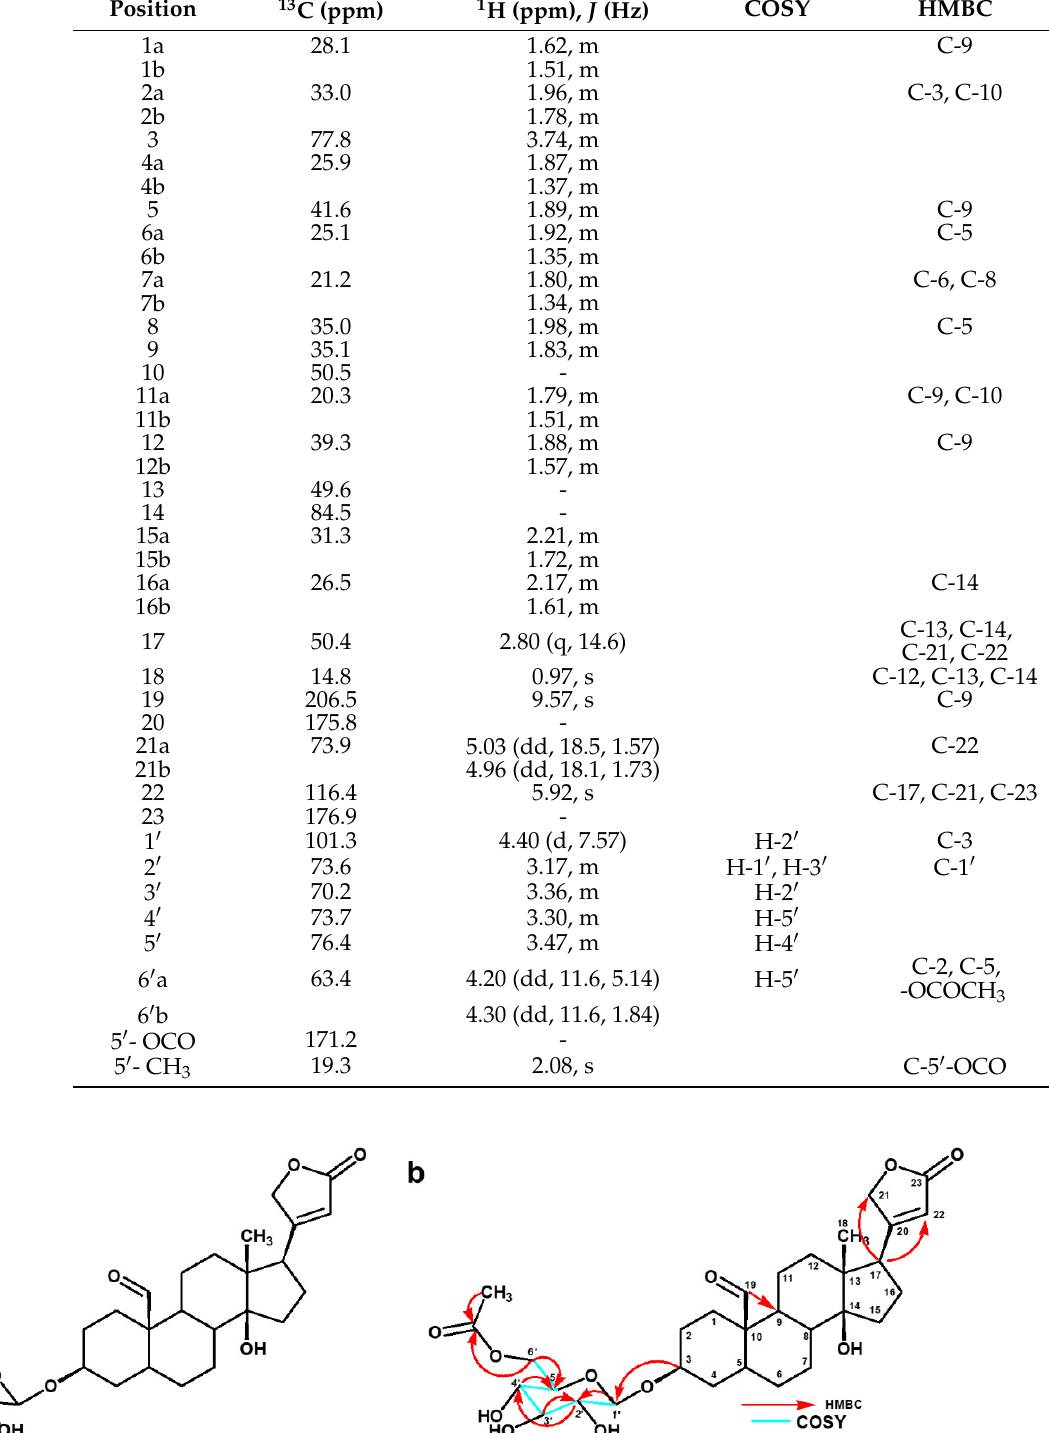
Figure 2. Cardenolide glycoside isolated from X. undulatum , ( a ) acetylated glycosydated crotoxigenin ( 1 ), and ( b ) its key HMBC and COSY correlations.